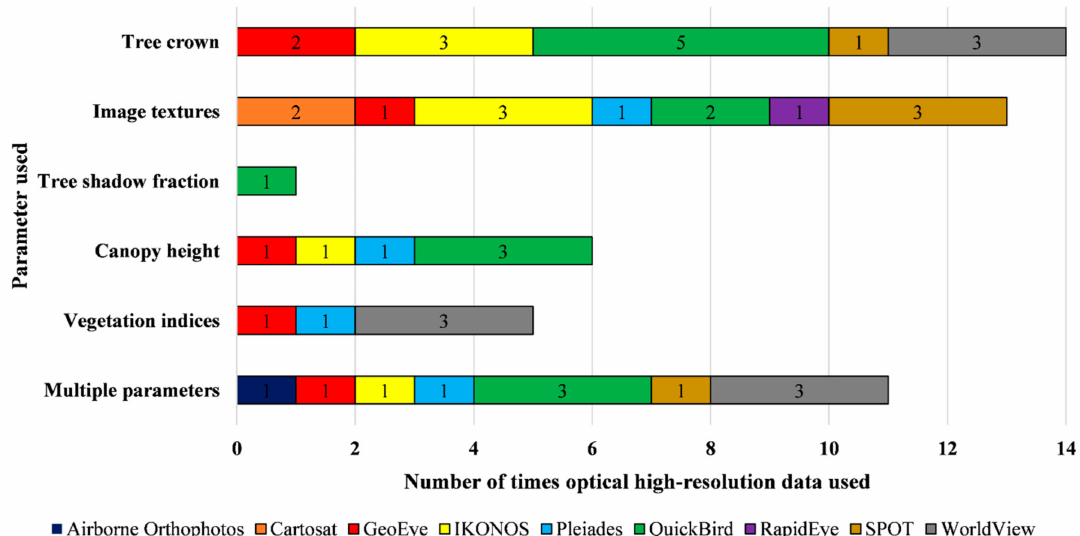
Figure 3. Satellite-derived independent variables for each satellite sensor used to calculate these specific variables.